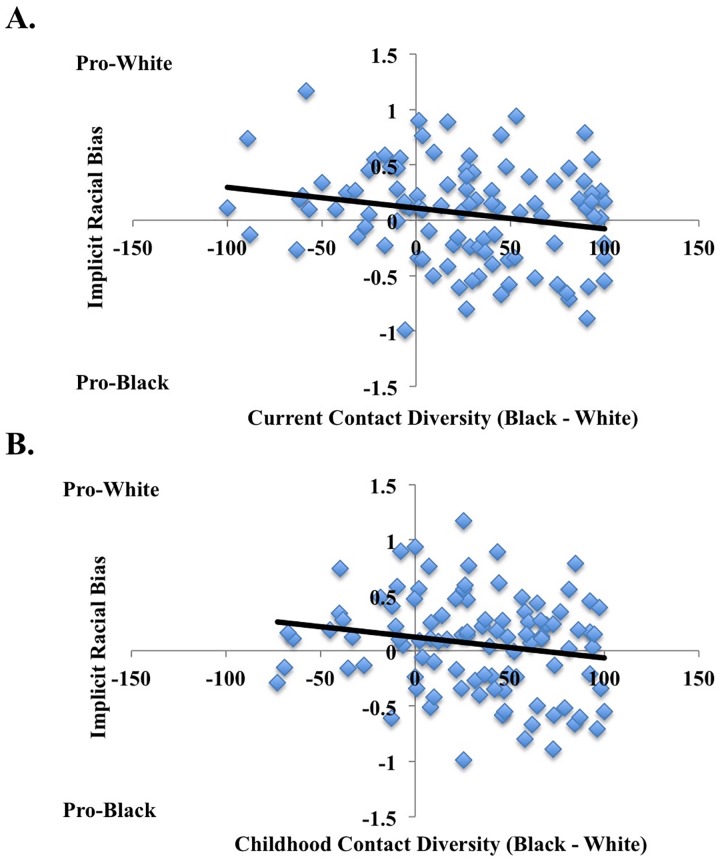
Relationship between current (Panel A) and childhood contact (Panel B) and implicit racial bias in Study 2 for Black participants. Higher values on implicit racial bias refer to more pro-White associations and lower numbers refer to more pro-Black associations. Overall, greater current ingroup contact (Black contact–White contact) related to lower own-group implicit racial bias (IAT D-scores).